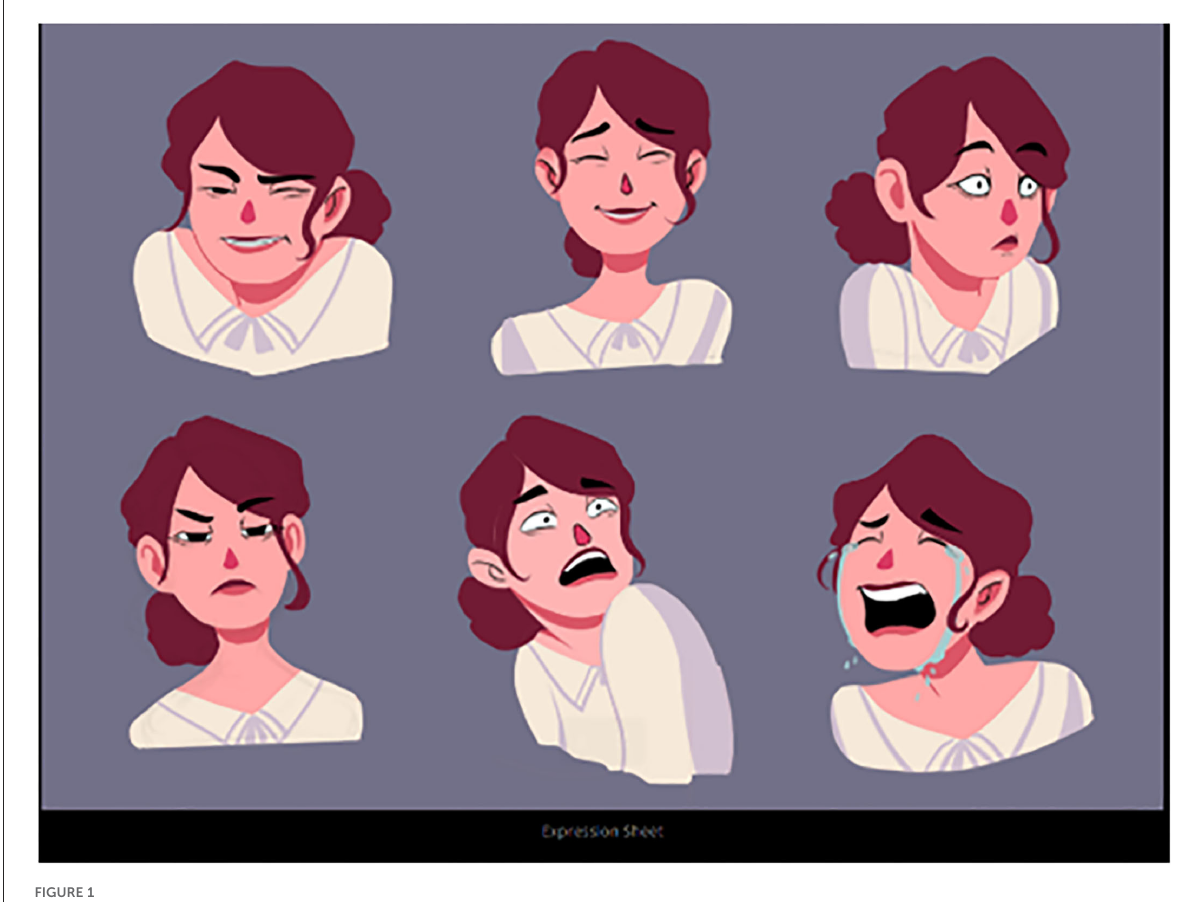
FIGURE1 Basic character expression sheet designed by Michelle Kham.